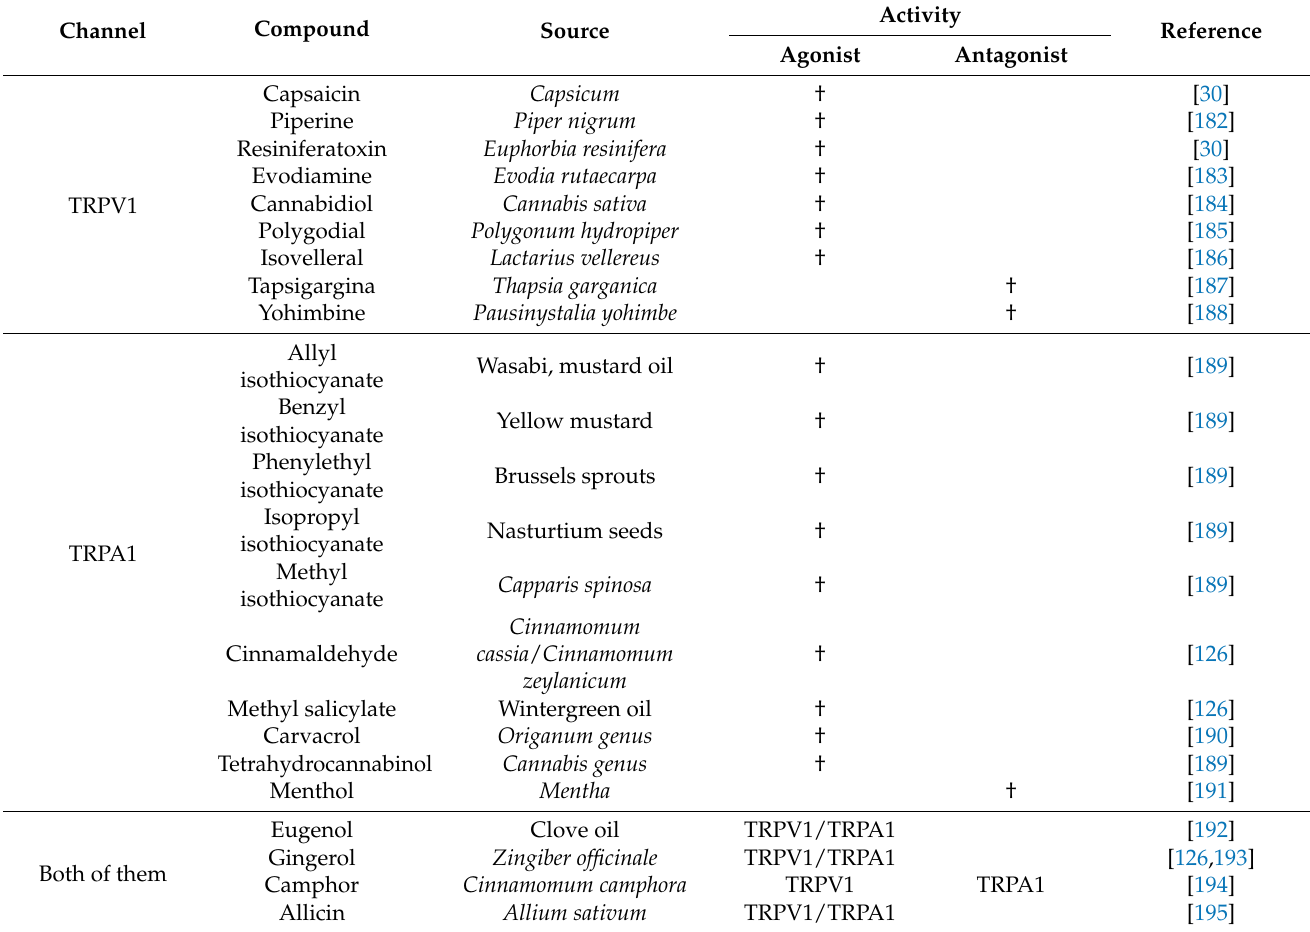
Table 1. Plant-derived compounds that could potentially modulate the activity of the transient receptor potential channels, TRPV1 and